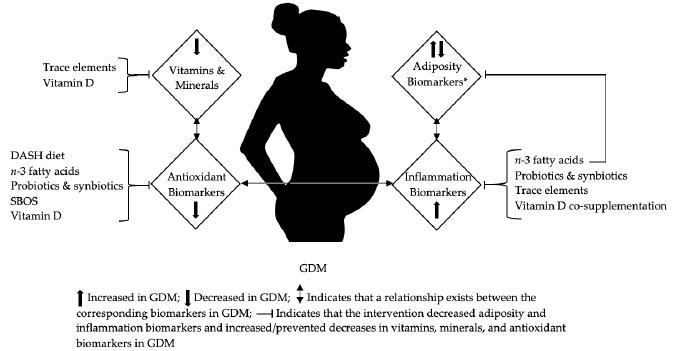
Figure 2. Effects of supplementing vitamins, minerals, and other dietary bioactive compounds on adiposity, vitamin and mineral status, antioxidant biomarkers, and inflammation in gestational diabetes mellitus (GDM). DASH: the Dietary Approaches to Stop Hypertension; SBOS: soybean oligosaccharides. * Only one RCT reported data on adiposity biomarkers (Supplementing SBOS increased adiponectin, Fei et al., 2014).